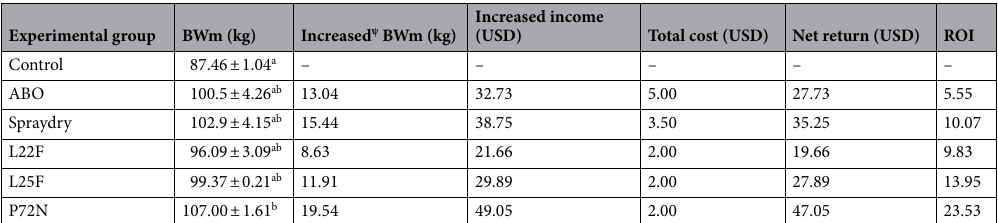
Table 1. Body weight at market age (BWm) and ROI per pig for probiotic and antibiotic supplementation. abc Means with different superscript differ significantly. ψ The increased BWms were derived from the comparison of the control group with the